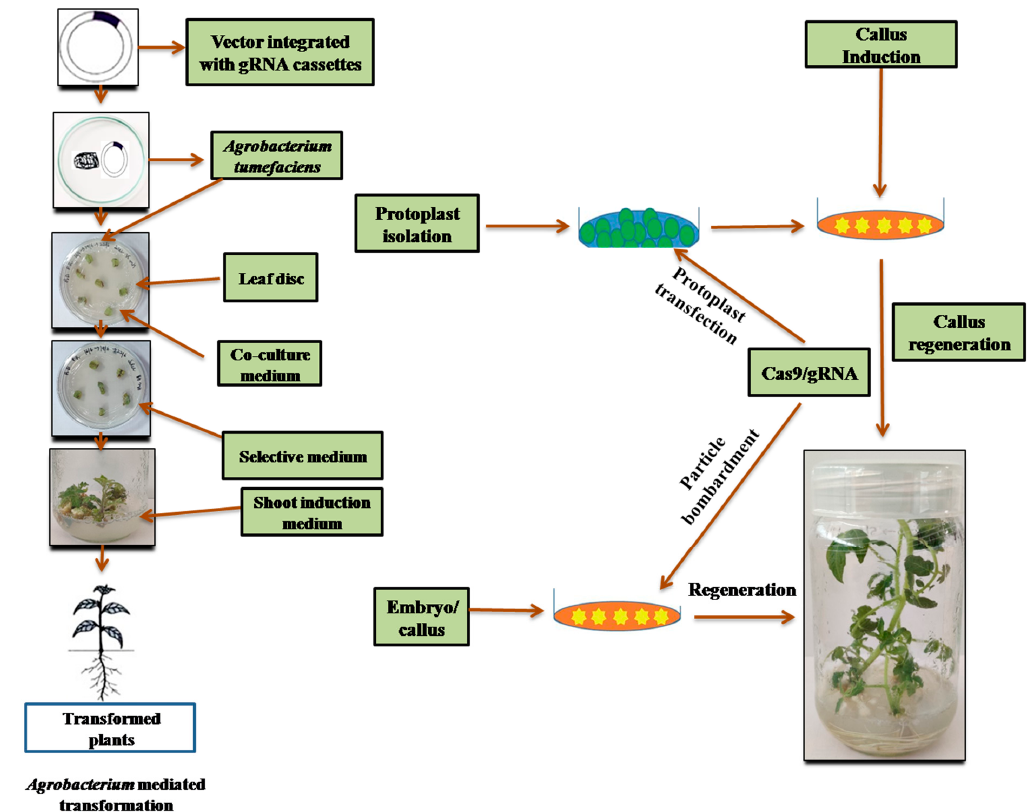
Figure 2: A simplified flowchart representation of steps involved in CRISPR/Cas9 mediated genome Figure 2. A simplified flowchart representation of steps involved in CRISPR / Cas9 mediated